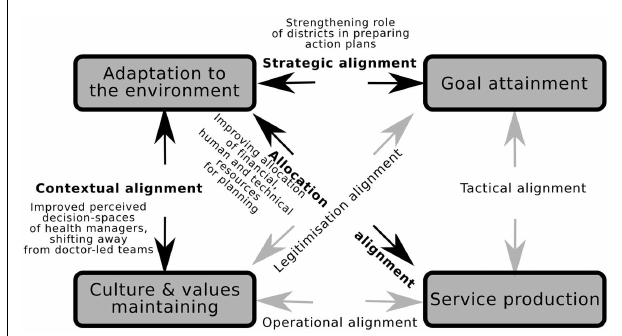
FIGURE 8 | Organizational change inTumkur could be explained through identifying which of the alignments in the Multipolar framework were triggered by the intervention inputs .The figure is based on the multipolar framework for assessing healthcare organization performance (28,